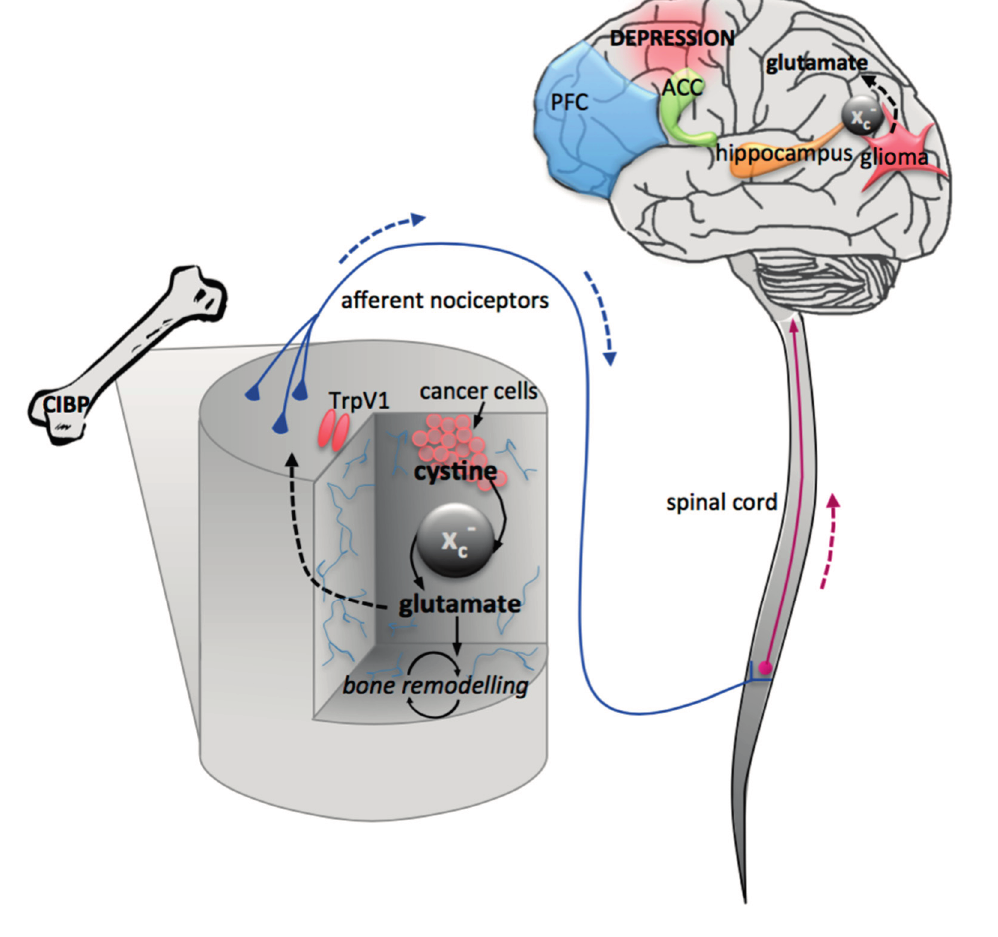
Figure 1. Schematic illustration of the relationship between glutamate dysregulation